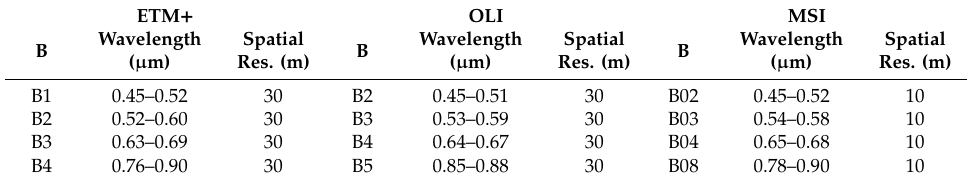
Table 1. Description of bands common to Enhanced Thematic Mapper Plus (ETM + ), Operational Land Imager (OLI) and MultiSpectral Instrument (MSI) sensors used to model the Moderate Resolution Imaging Spectroradiometer (MODIS)-Normalized Di ff erence Vegetation Index (NDVI). ETM + OLI